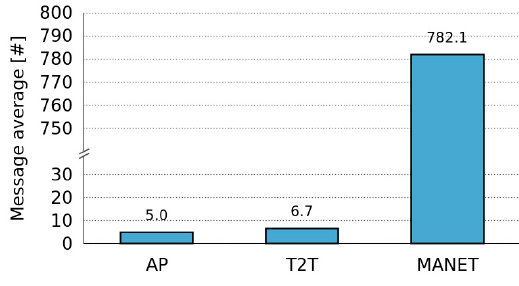
Figure 13. Average number of messages for different network infrastructures.